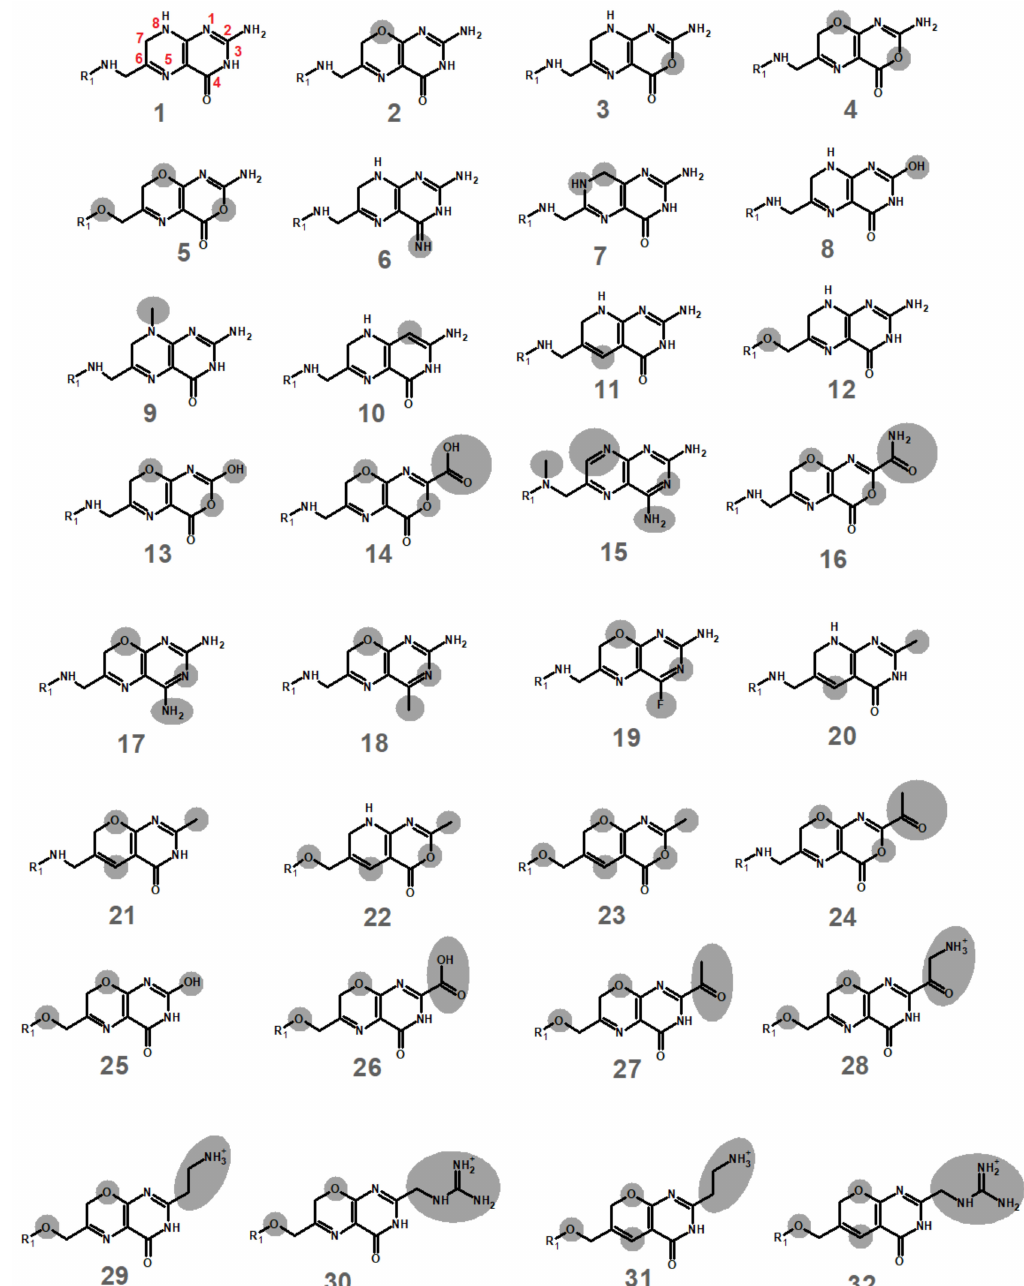
Figure 1. Putative inhibitors tested in this work. Differences from dihydrofolate (molecule 1 ) are highlighted in grey. The pteridine core of methotrexate (which does not inhibit the plasmid-borne dihydrofolate reductase [3]) is depicted as molecule 15